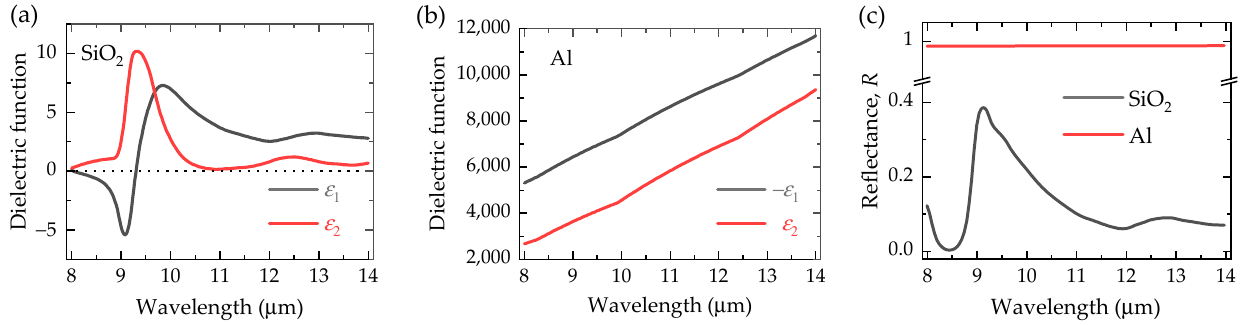
Figure 3. The dielectric functions of ( a ) SiO 2 and ( b ) Al. It is noted that the complex dielectric function is represented as ε = ε 1 + i ε 2 . ( c ) The normal reflectance of semi-infinite Al and SiO 2 substrates. The spectral range is selected for 8–14 µm.